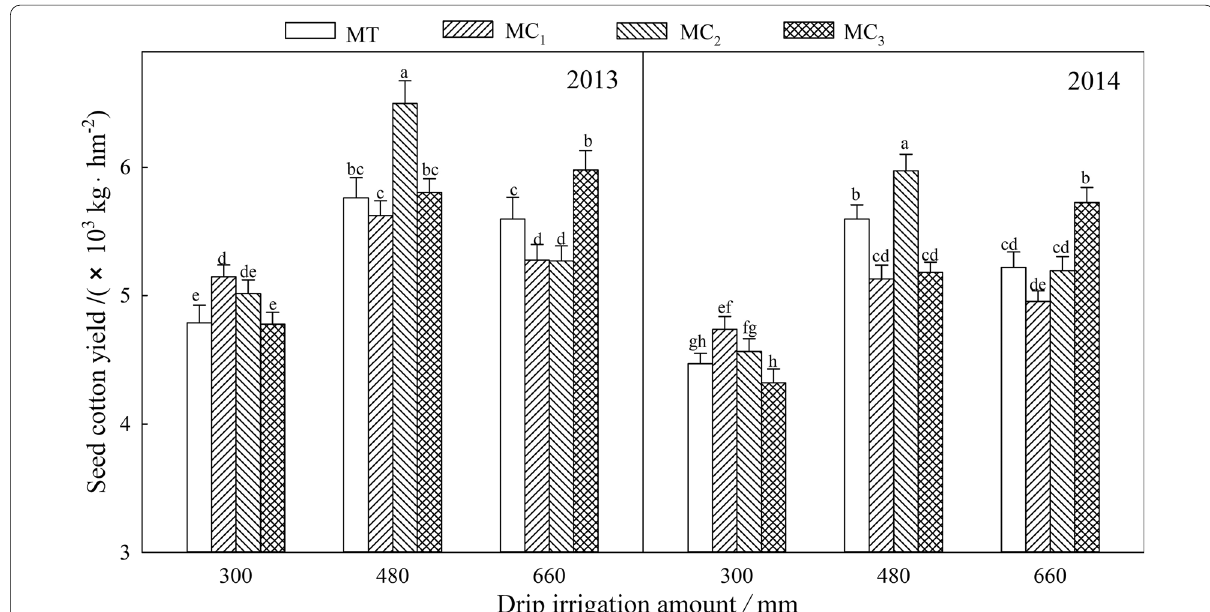
Fig. 2 The effect of MC EW on seed cotton yield under different drip irrigation amounts (Han et al. 2017). MC EW represents a 25% mepiquat chloride emulsion in water; MT, MC